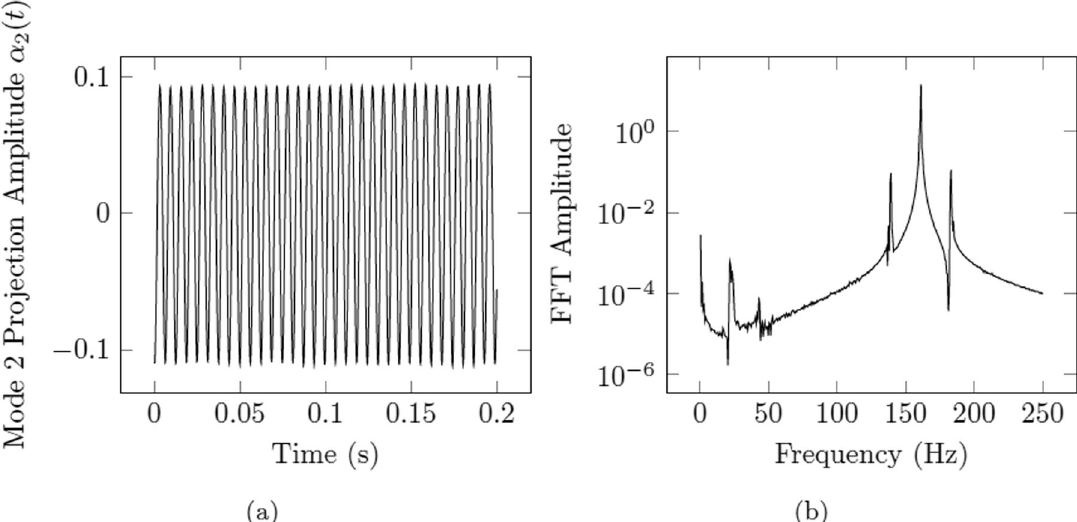
Fig. 10 Dynamic output of the projection method for a droplet subjected to modal oscillations. a The dynamic projection amplitude, α 2 ( t ) as a function of time, is computed for each forcing frequency after completing the image analysis procedure described in Fig. 9. b Logarithmic representation of the FFT amplitudes of the dynamic projection amplitude. The maximum peak corresponds to the dominant frequency of oscillation in the droplet.